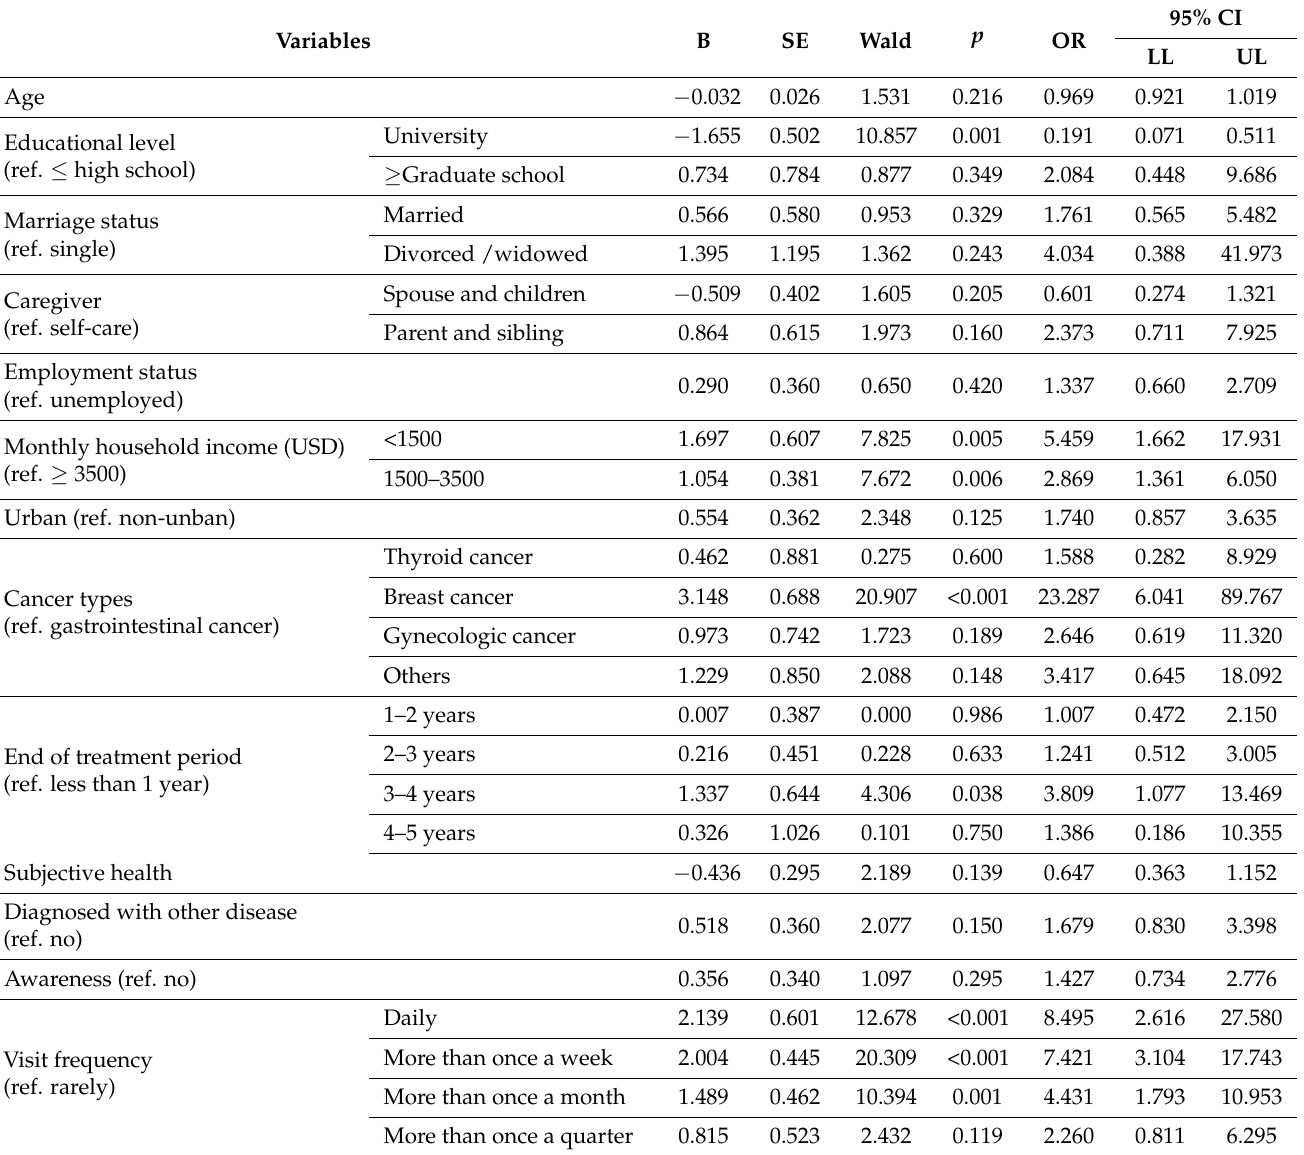
Table 5. Result of the binary logistic regression for intention for forest healing program (N =